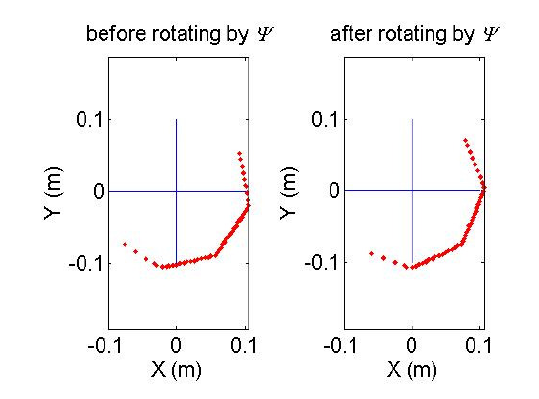
Figure 4. Projected 2D image from the point cloud for calculating approximate value of Ψ (4a, left): before rotating by Ψ ; (4b, right): after rotating by Ψ 3. EXPERIMENT A full errorless vertical octagonal lamp pole was simulated with